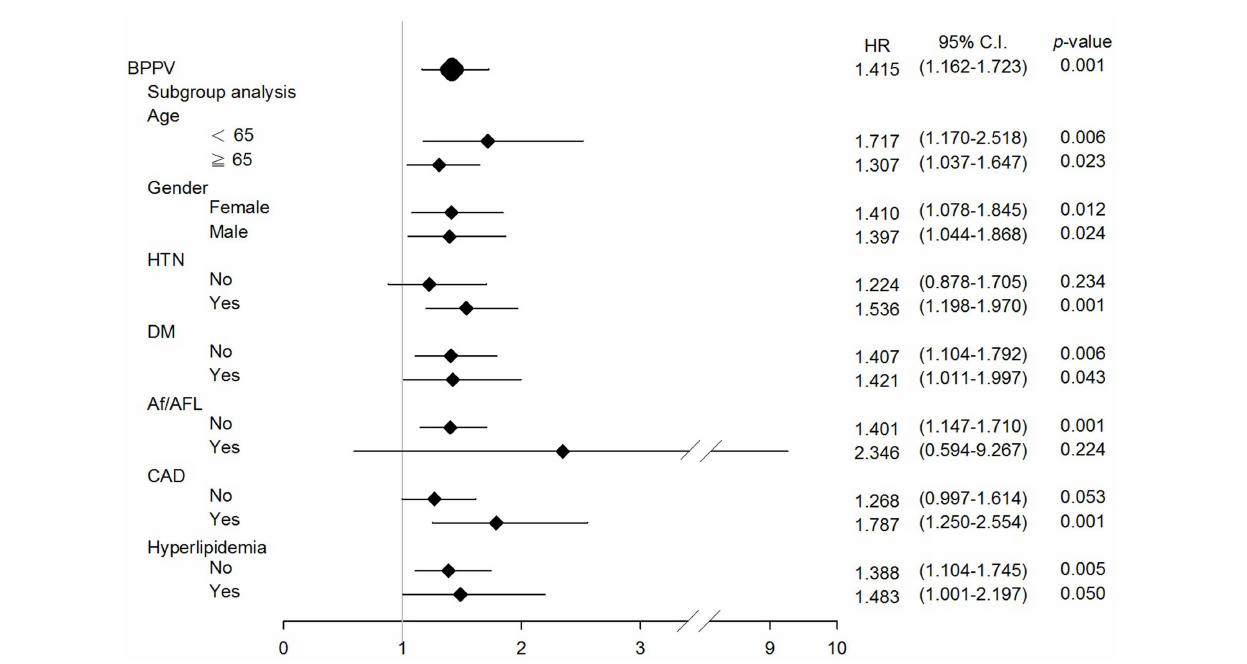
in male = 1.307; Figure 2 ). Age and gender-related factors cannot explain the association of BPPV and formation of ischemic strokes or other cardiovascular